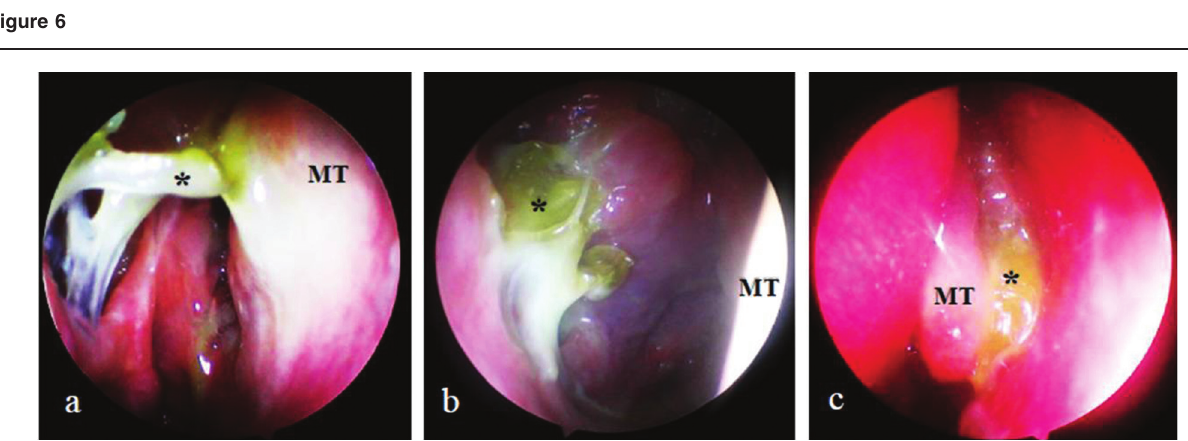
Nasal endoscopy showing: (a) Crustations* mildly obstructing the maxillary antrostomy in Merocel packed on the right side 2-month postoperatively. (b) Mild crusts in Merocel packed on the right side 1-month postoperatively. (c) Marked crust formation obliterating the middle meatus in Gelfoam packed on the left side 1-month postoperatively. MT, middle